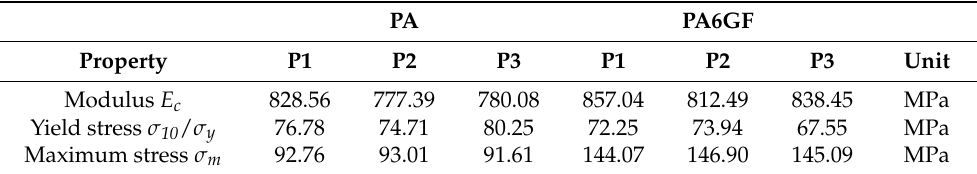
Table 6. Results of the compression tests on dry-as-mold